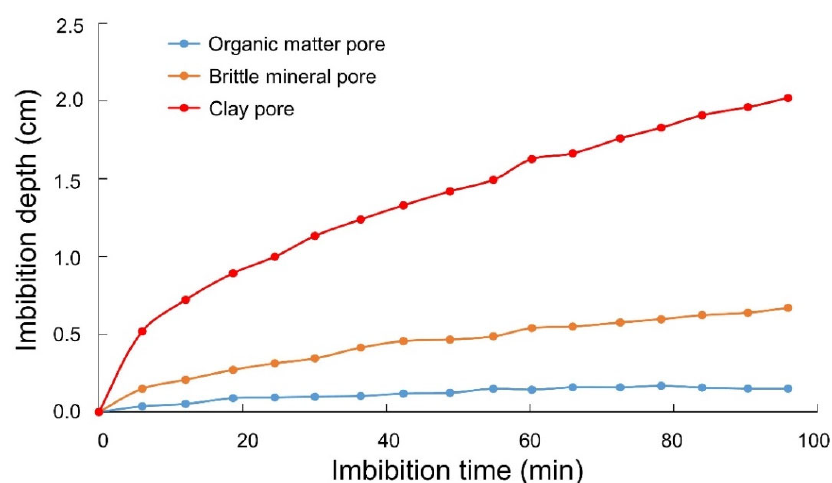
Figure 15. Relationship curves of imbibition depth vs. time of different types of pores.